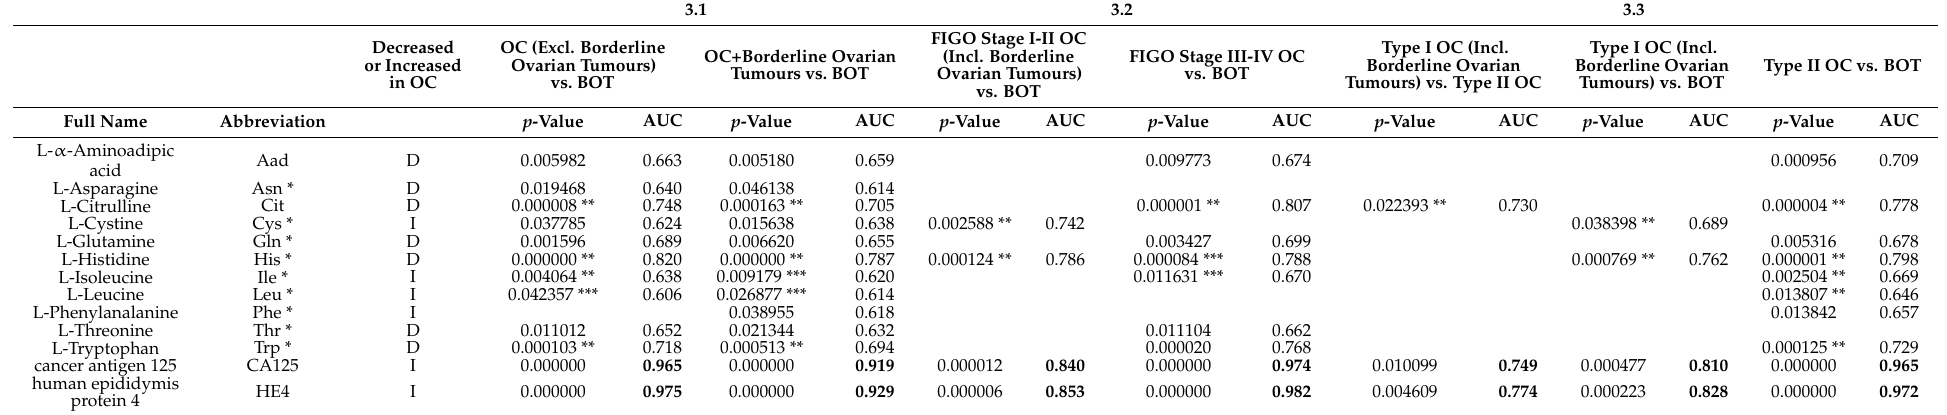
Table 3. Serum free amino acids and ovarian cancer markers (CA125 and HE4) showing significant p -values ( p < 0.05) and corresponding areas under the receiver operating characteristic (AUC of ROC) curves in differential diagnosis between the analyzed groups. The highest obtained AUC in each group is in bold.